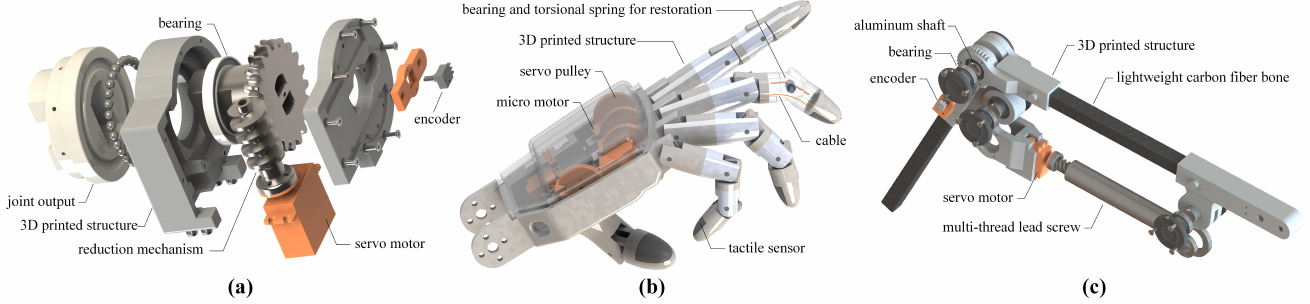
Figure 3. Workspace of the ( a ) dual arm system and the ( b ) zero-g legs of Taikobot (dimensions in mm).